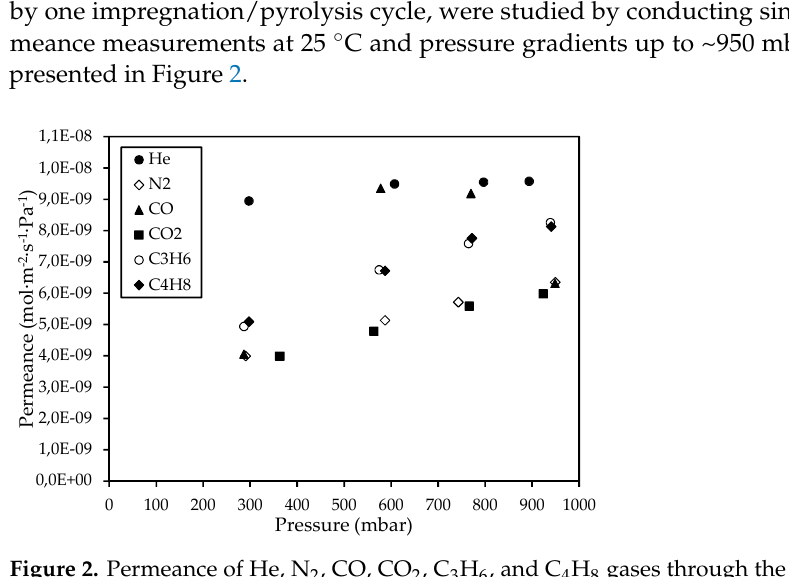
Figure 2. Permeance of He, N 2 , CO, CO 2 , C 3 H 6 , and C 4 H 8 gases through the CM_1 membrane at Figure 2 . Permeance of He, N 2 , CO, CO 2 , C 3 H 6 , and C 4 H 8 gases through the CΜ_1 membrane at 25 25 ◦ C, with respect to the °C, with respect to the pressure.